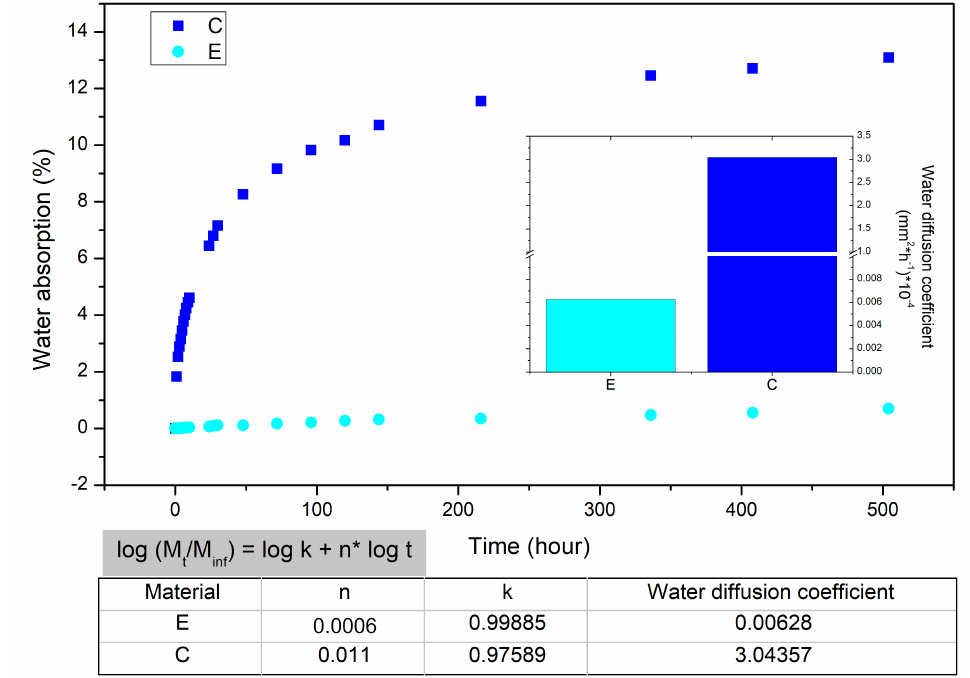
Figure 3. Weight variation of epoxy (E) and fique fabric–reinforced epoxy matrix composite (C) during water immersion